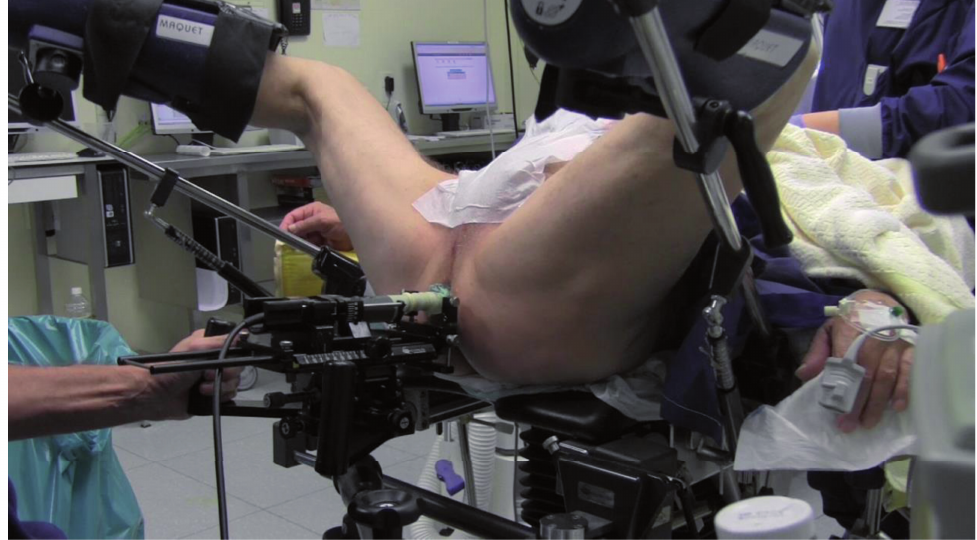
figure 4 - The setup: patient is placed in dorsal lithotomy position, with brachytherapy stepper unit and TRus probe.